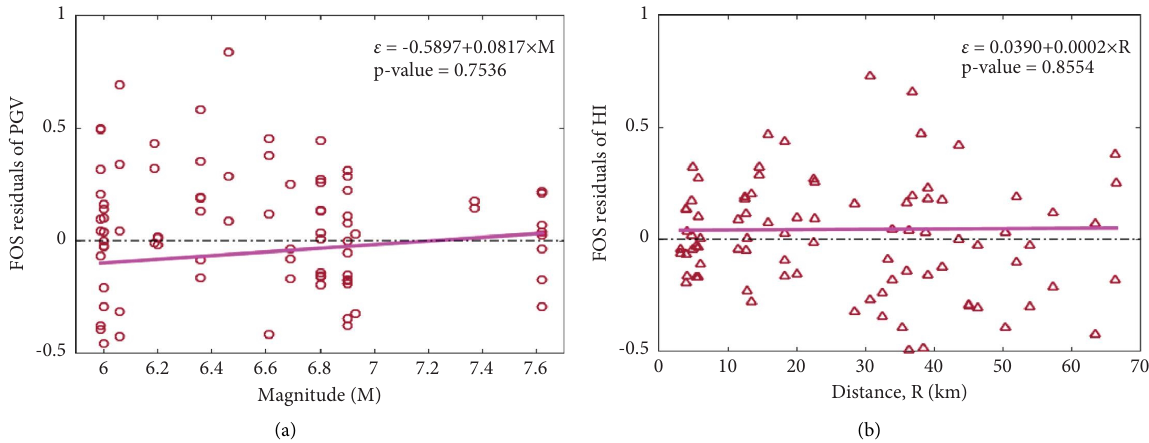
Figure 12: Illustration of IM sufciency against M and R using p value for the slope with 50 m mining depth. (a) PGV with respect to M . (b) HI with respect to R